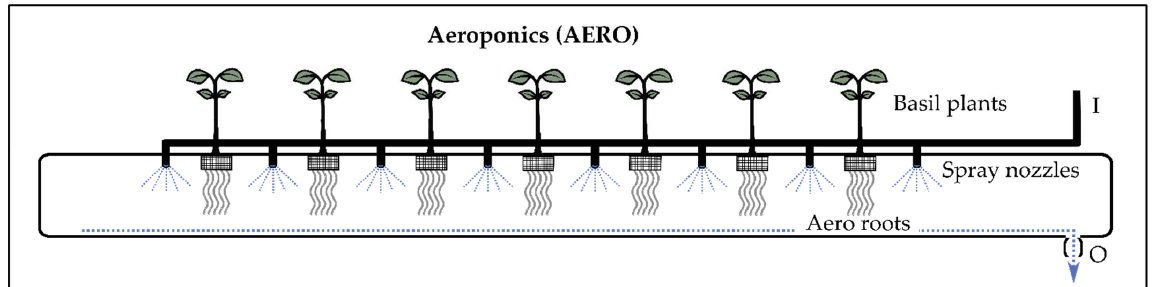
Figure 3. Schematic illustration of the aeroponics system (AERO). I = inflow, O = outflow.